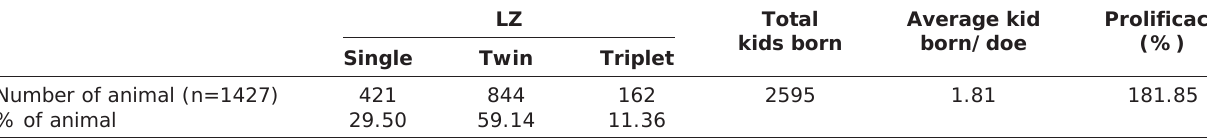
Table-2: Indian Black Bengal goats with different LZ groups and